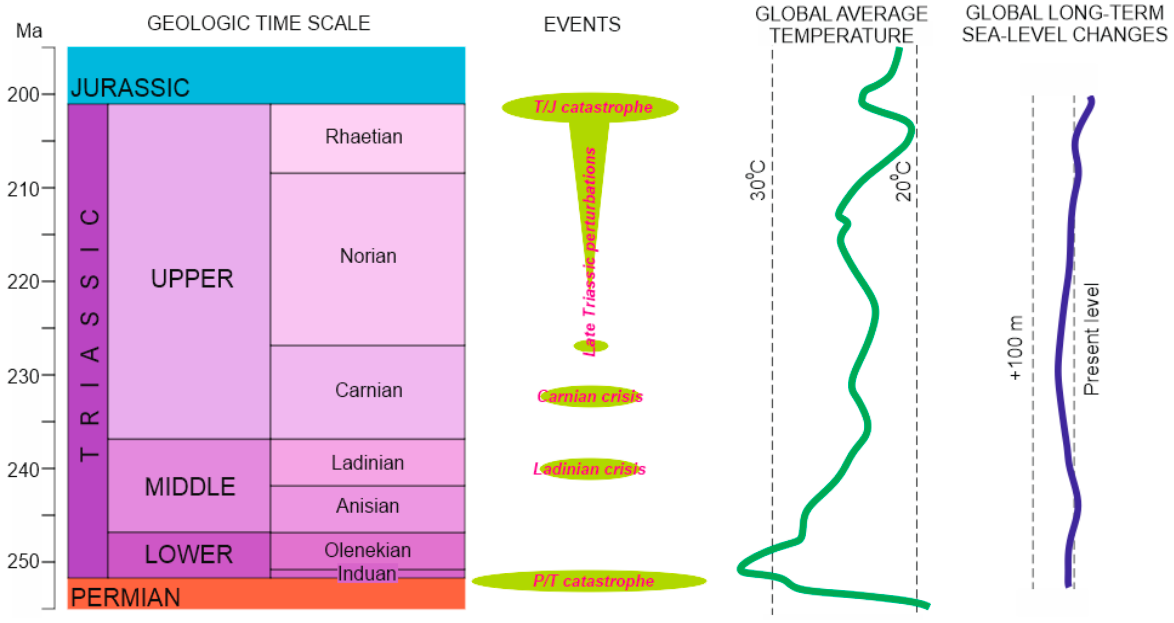
Figure 1. Selected patterns of the Triassic history of the Earth (geologic time scale follows [32], events according to Ruban [45], global average temperature is modified from [34], and global long ‐ term sea ‐ level changes are modified from [35]). One should note the well ‐ developed but disproportional geologic time scale, which may reflect the changed tempos of the planetary evolution. Biotic perturbations were very frequent, with two major catastrophes and several smaller crises. The Earth was warm, but the palaeotemperatures fluctuated significantly. The global sea level remained generally low, although it peaked in the first half of the Late Triassic.